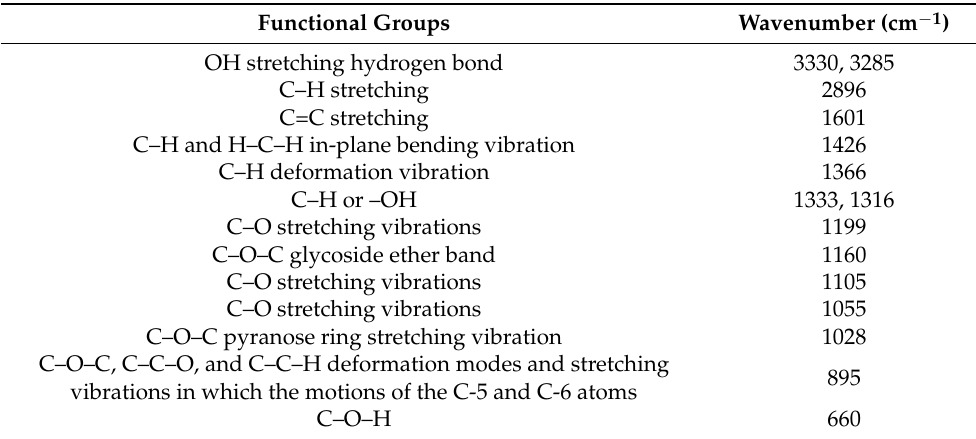
Figure 1. FTIR (Fourier Transform Infrared Spectroscopy) spectrum of microcellulose. Table 3 . Identification of peaks in FTIR spectrum [37,38,39].